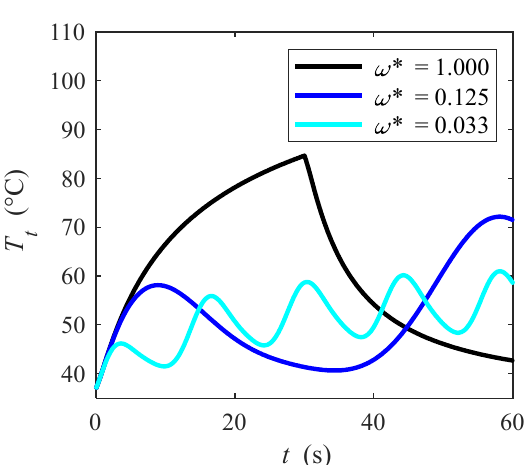
Figure 5. Tissue temperature vs. time for different dimensionless period ω * in P(0.0000, − 0.0400, 0.0175).